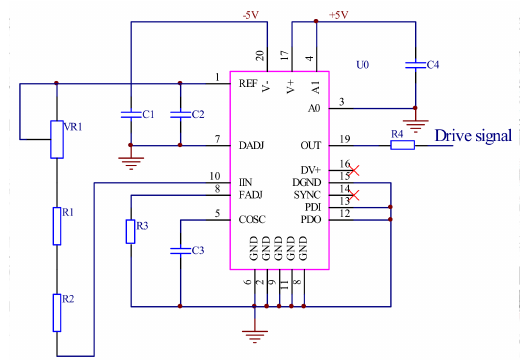
Figure 5. The drive signal generating circuit.